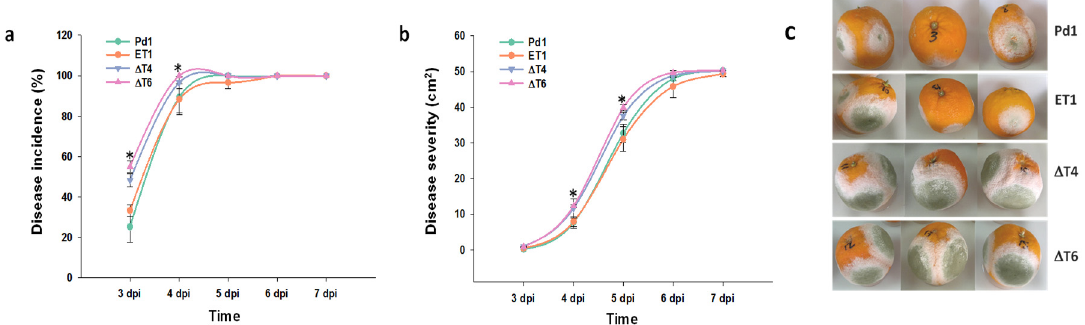
Figure 3. Analysis of fungal infection. ( a ) Disease incidence (%) and ( b ) disease severity (cm 2 ). Virulence assessment of Pd1, ectopic transformant ET1, and disruptant transformants ( Δ T4, Δ T6). All are means of two infection experiments. Error bars represent standard deviation. * Significant differences between treatments using Tukey’s test ( p < 0.05) at each dpi. ( c ) Representative images of infected oranges at 5